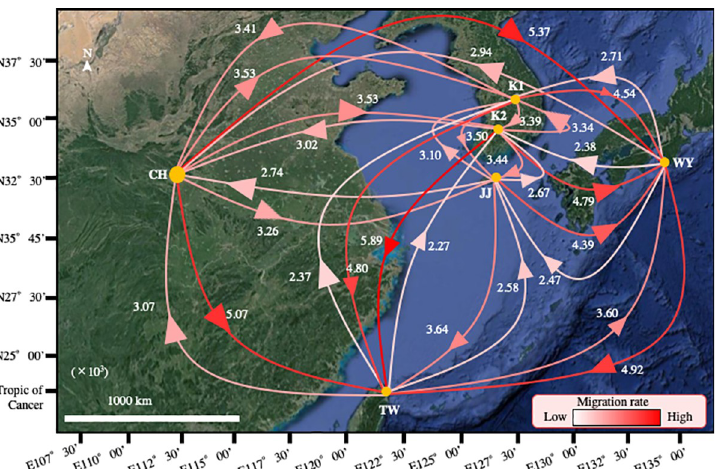
Fig 2. Gene flows among the populations of M . fuliginosus in east Asia. The gene flows were estimated, based on the D-loop amplicon-sequencing results, determined by analysis with Migrate-n software. The arrowheads on the lines show the directions of gene flows and the numbers near the arrowheads are the relative values of the gene flows ( × 10 3 ).